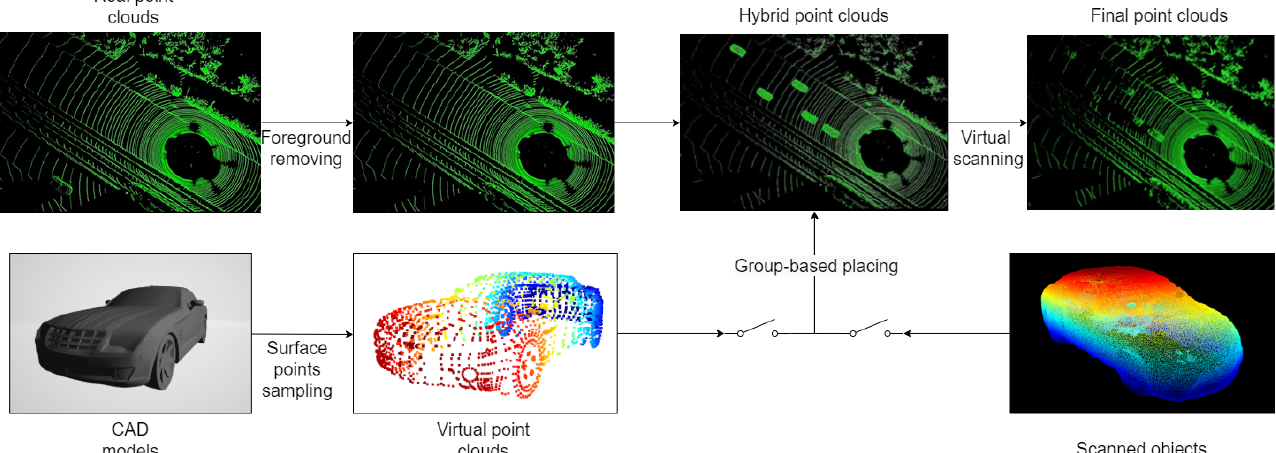
Figure 3. The illustration of our hybrid point cloud integration pipeline. Firstly, foreground models are converted to point clouds. Secondly, an empty background is generated by removing existing objects. Thirdly, the background and foreground are integrated with the proposed ground-based placing algorithm. Finally, foreground objects are virtually scanned by the virtual